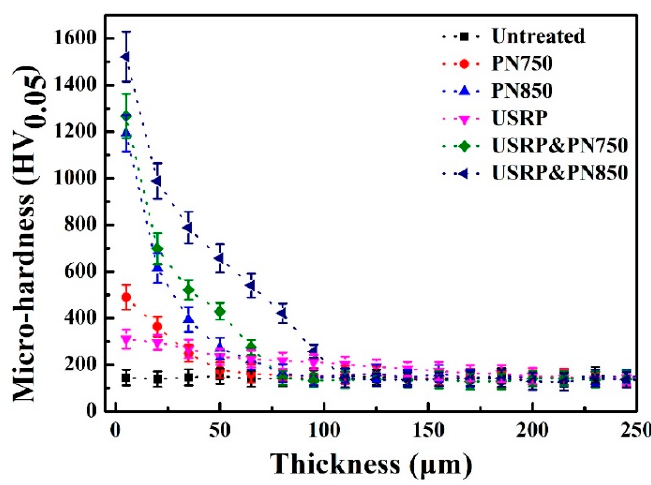
Figure 6. Micro-hardness of plasma-nitrided Ti pre-treated by USRP against the thickness.